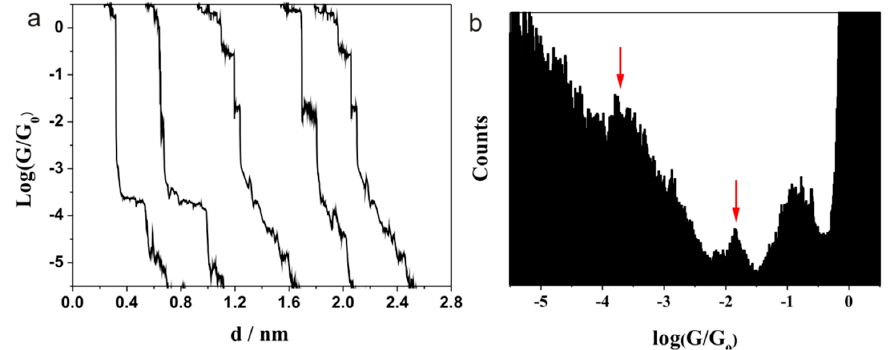
Figure 2. Typical conductance ( a ) curves and ( b ) histogram of alanine (from 1000 curves) contacting with Au electrode at a bias of 100 mV.